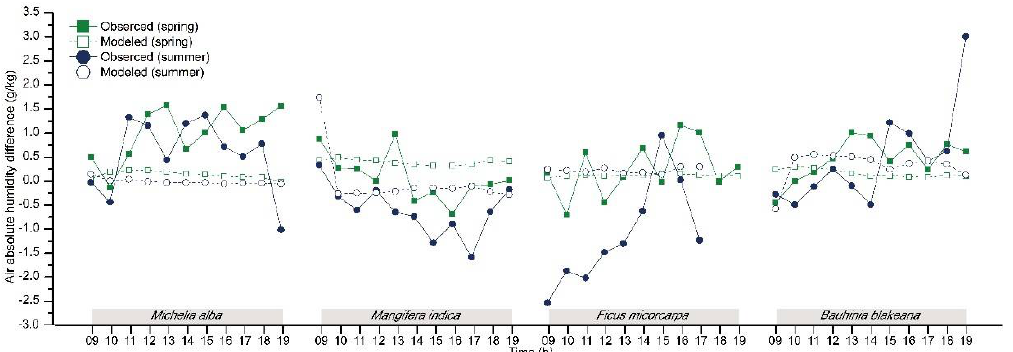
Figure 12. Comparison of modeled and observed air absolute humidity difference between treeless areas and canopy shade areas.